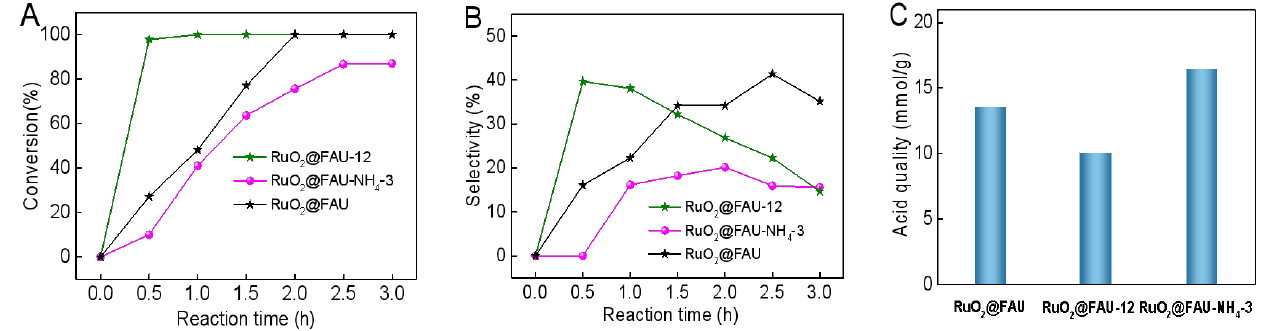
Figure 6. Decarboxylation of L-lysine to cadaverine with RuO 2 @FAU, and RuO 2 @FAU-12 and RuO 2 @FAU-NH 4 -3 catalysts. ( A ) variation of conversion with reaction time, ( B ) variation of the selec-